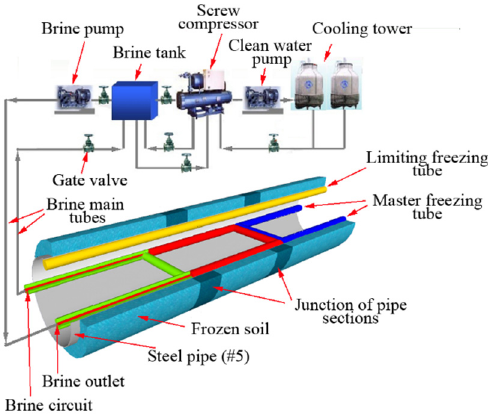
Figure 8. Layout of freezing system. Figure 8 . Layout of freezing system. Figure 8 . Layout of freezing system.